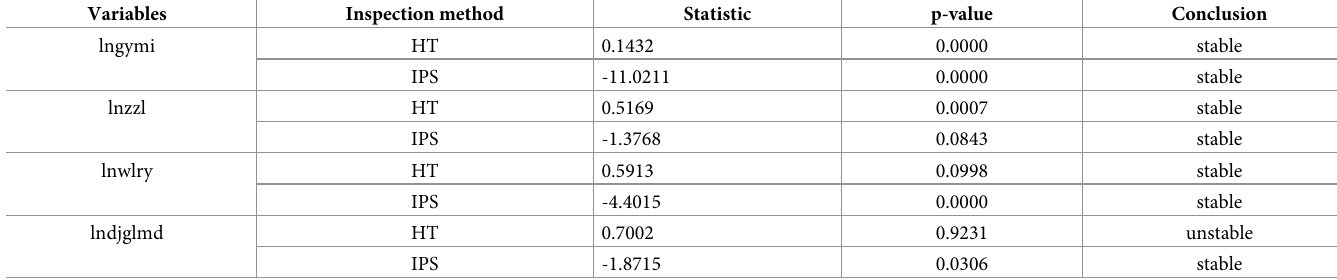
Table 11. Description of unit root test results of variables.